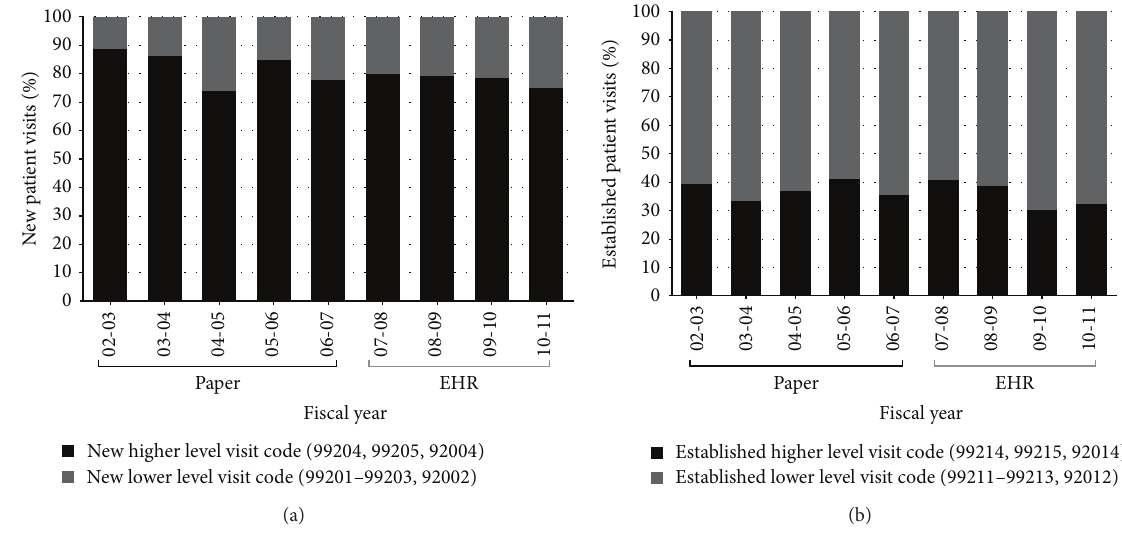
Figure 2: (a) Proportion of new patient and (b) established patient higher and lower level visit codes during the period of paper and of EHR documentation.